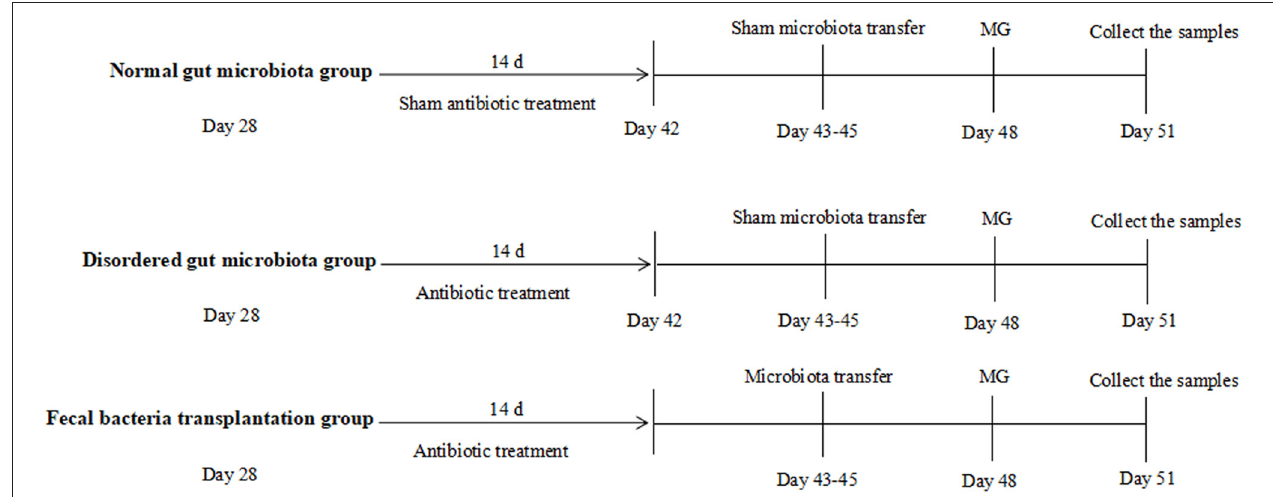
FIGURE 1 | Schematic outline of the experimental protocol used in the present study. Details showed in the Materials and method